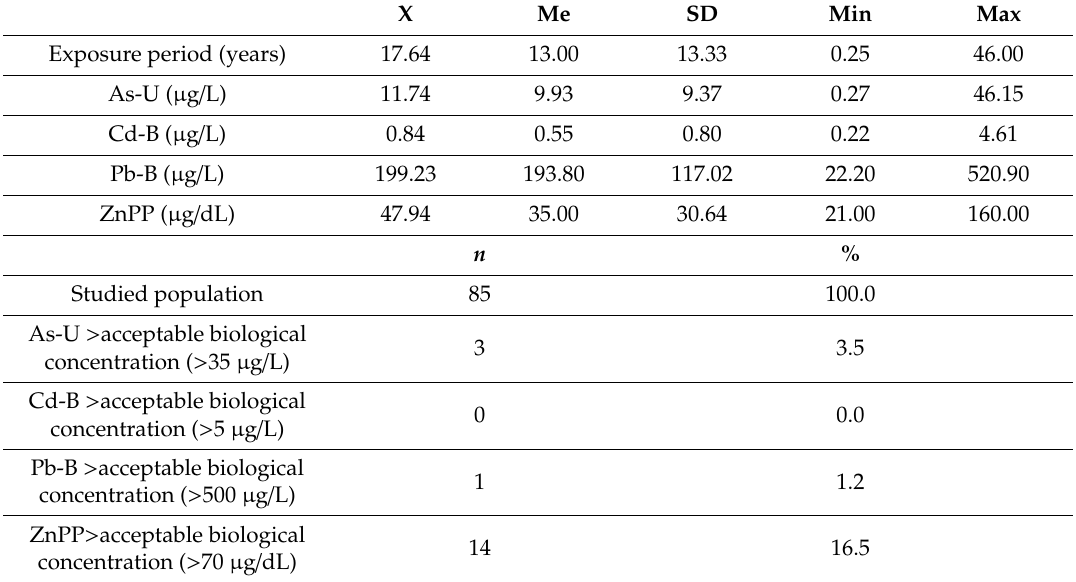
Table 3. Basic toxicological parameters in the study population.